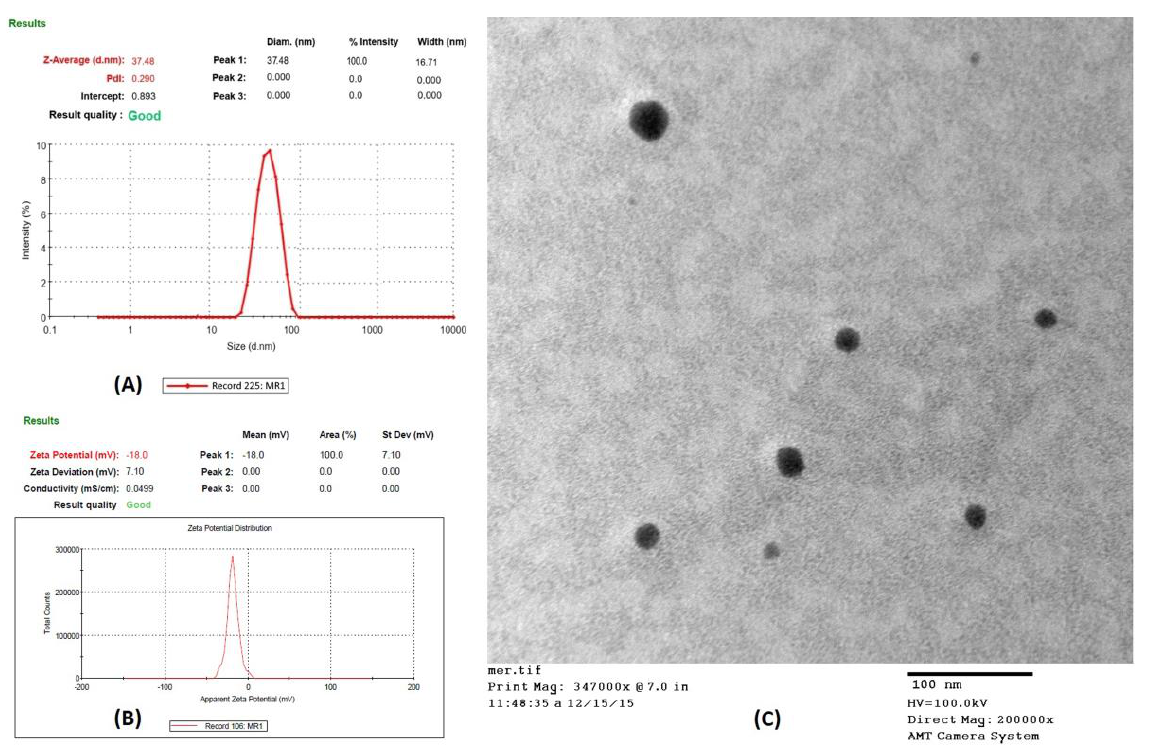
Figure 3. Characterization of optimized nanoemulsion (NE2): ( A ) Particle size distribution curve; ( B ) Transmission electron microscopy (TEM) analysis; ( C ) Zeta potential of NE2